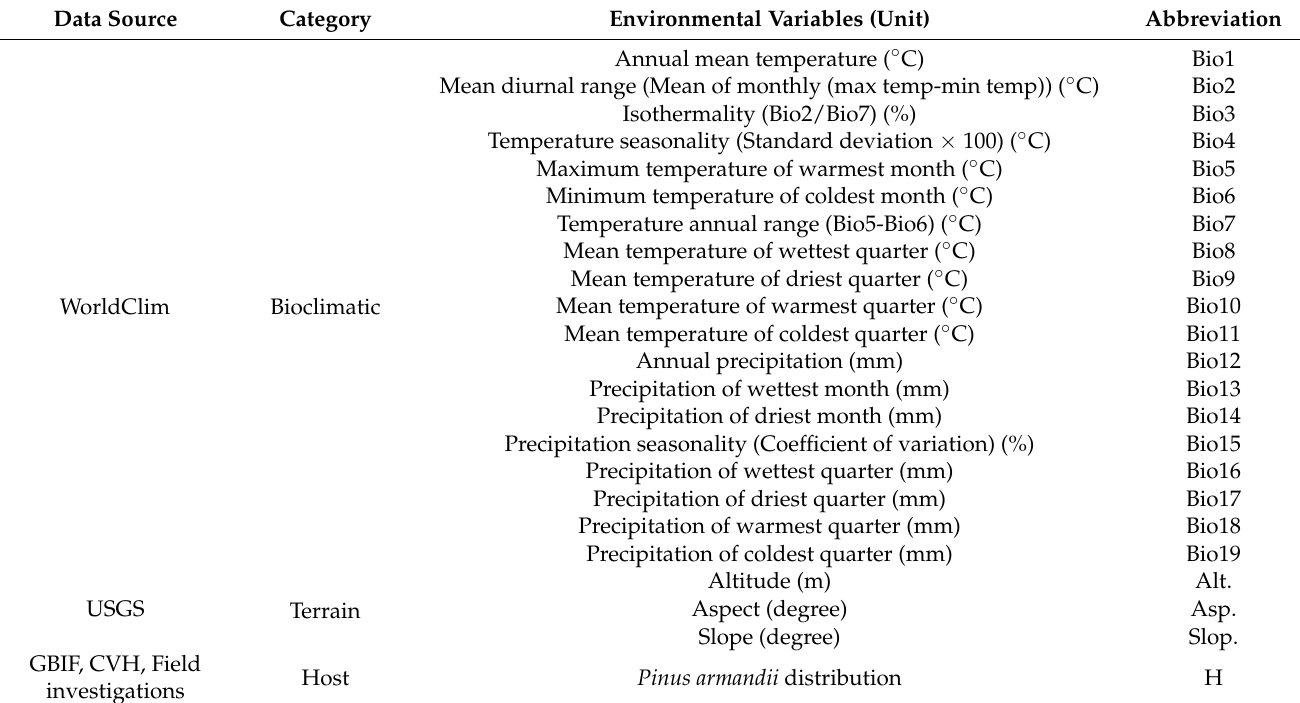
Table 1. Description of environmental variables used for modeling the habitat suitability distribution of Dendroctonus armandi in this